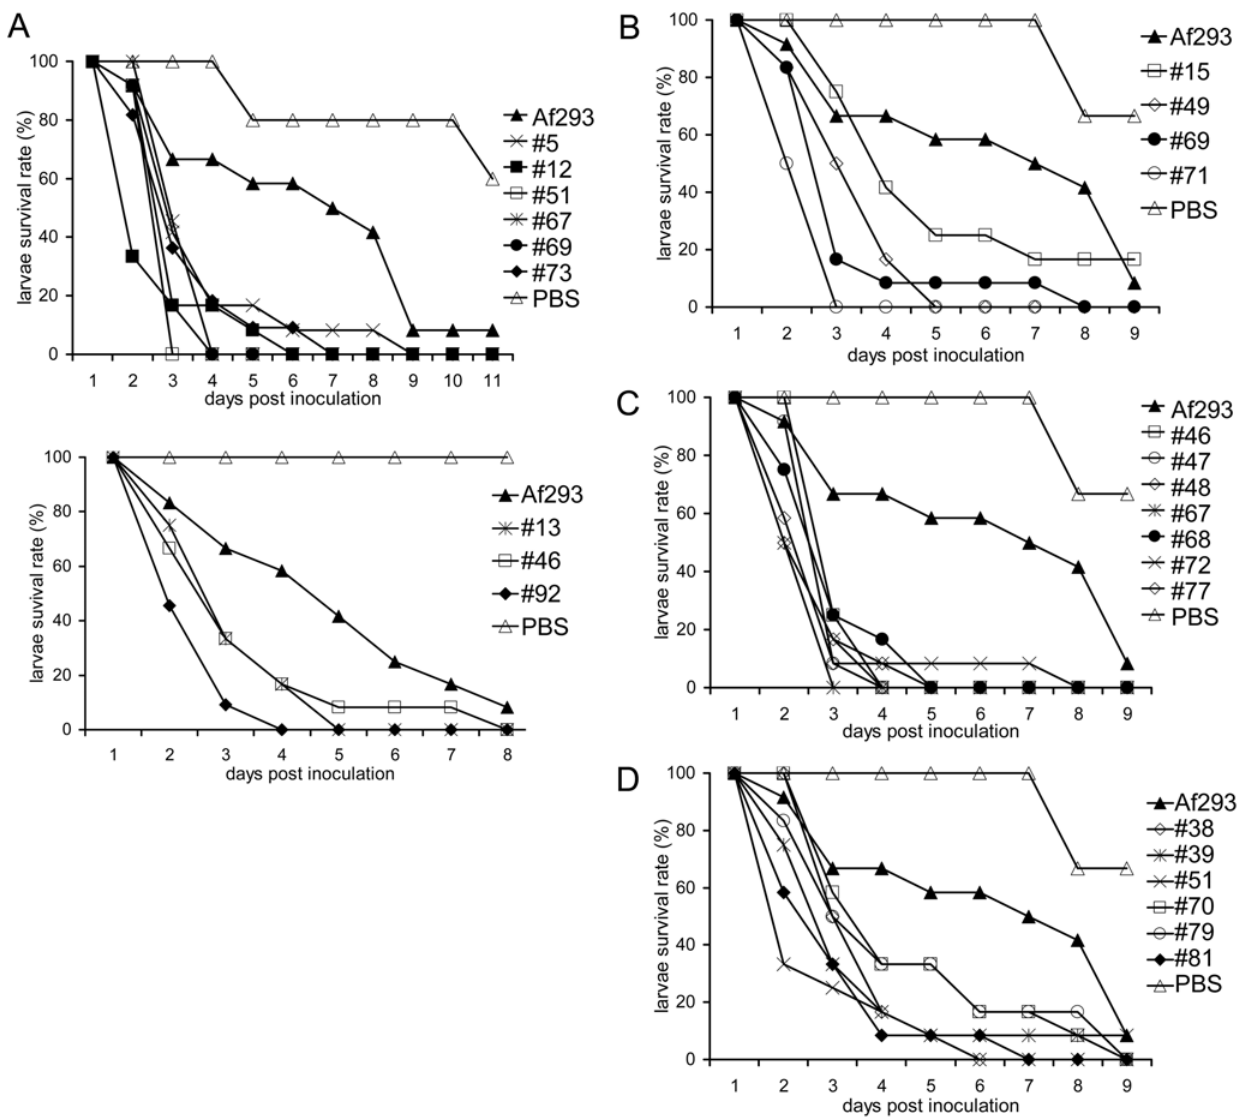
Figure 7. A.fumigatus color mutants in the Af293 background show enhanced virulence in the G.mellonella model. Larvae were inoculated with conidia of wild type and color mutants at concentrations of 1 6 10 6 conidia per caterpillar. Percent G. mellonella survival was plotted against days post inoculation. ( A ) Color mutant representatives show an increased virulence that is statistically significant compared to the wild type strain Af293: # 5 (p=0.0193), # 12 (p=0.0038), # 13 (p=0.0062), # 46 (p=0.0067), # 51 (p=0.0038), # 67 (p , 0.0001), # 69 (p , 0.0001), # 73 (p=0.0003), and # 92 (p=0.0053). ( B ) Brownish green color mutants # 49 (p , 0.0001), # 69 (p , 0.0001) and # 71 (p , 0.0001) show increased virulence compared to the wild type strain Af293, while # 15 (p=0.1048) does not appear to have a statistically significant difference in virulence. ( C ) Brown color mutants all show increased virulence compared to the wild type strain Af293 that is statistically significant: # 46 (p , 0.0001), # 47 (p , 0.0001), # 48, (p , 0.0001), # 67 (p , 0.0001), # 68 (p , 0.0001), # 72 (p , 0.0001), and # 77 (p , 0.0001). ( D ) Color mutants, which produce green conidia at the front edge and brown conidia at the center of the colony as colonies age, show a statistically significant increase in virulence compared to the wild type strain Af293: # 38 (p , 0.0001), # 39 (p , 0.0001), # 51 (p , 0.0001), # 70 (p=0.0026), # 79 (p=0.0009), and # 81 (p ,